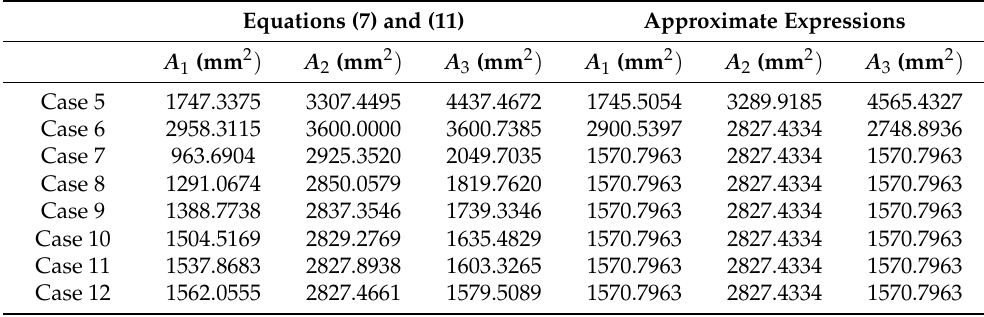
Table 4. Summary of the results for intersection areas for extended test